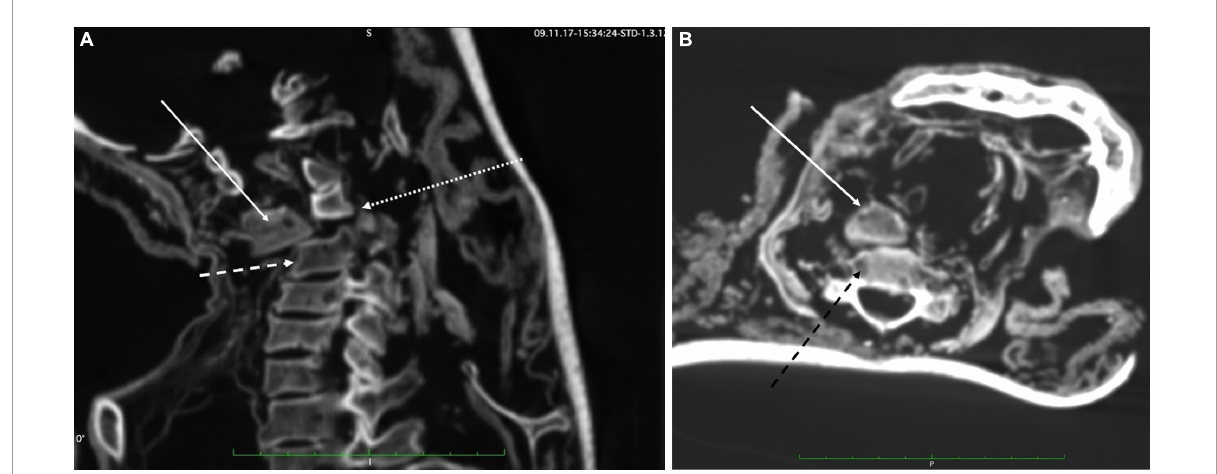
FIGURE12 (A) Sagittal CT-scans through the cervical spine: There is a significant dislocation (small dotted arrow) between C3 (arrow) and C4 (dotted arrow) that may have resulted from a massive forward flexion. (B) The axial scan confirms the dislocation along with the surrounding intact soft tissue (white arrow = body C3; dark doted arrow = body